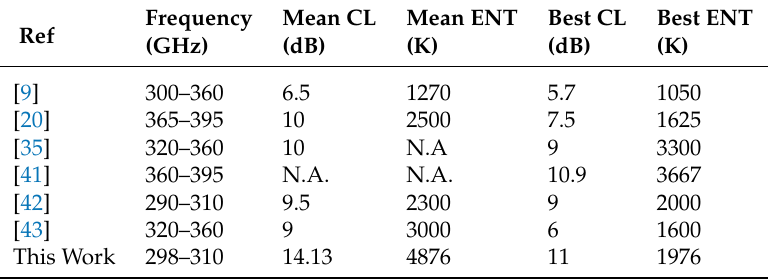
Table 3. State of the art of Schottky diode mixers working at similar frequencies to this work.